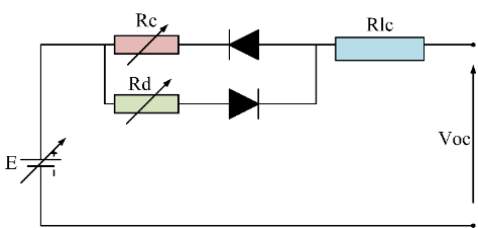
Figure 34. The equivalent circuit model of NaS cell based on the effect of depth of discharge (DoD) and temperature on the electromotive force (EMF) and internal resistance [19].